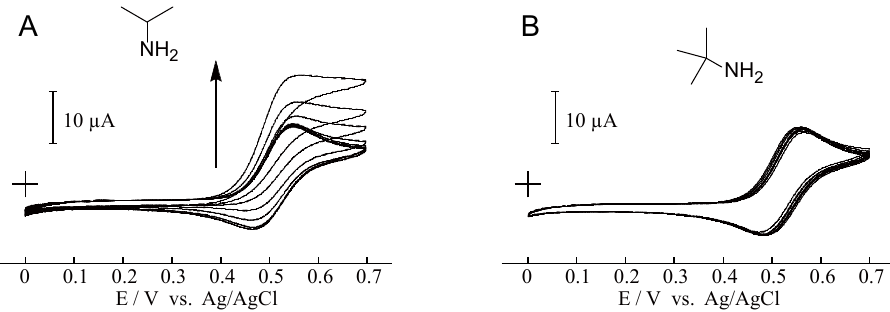
Figure 5. Cyclic voltammograms of NNO (1 mM) in the absence and presence of 1, 5, 10, 50, and 100 mM ( A ) isopropylamine and ( B ) tert -butylamine in 100 mM phosphate buffer solution (pH 7.4). Scan rate was 100 mV s − 1 .